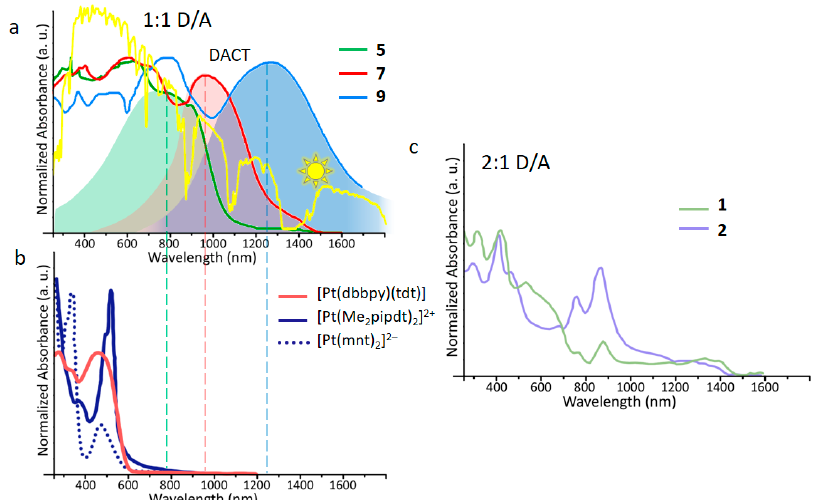
Figure 1. Normalized diffuse reflectance spectra of crystalline samples of: ( a ) 5 (green), 7 (red) and 9 (blue), evidencing the DACT band (shadowed area) in the NIR and the overlap with the AM1 solar spectrum (yellow); ( b ) [Pt(dbbpy)(tdt)], donor unit of 5 and 7 (red), [Pt(mnt) 2 ] 2 − (blue dotted line) and [Pt(Me 2 pipdt) 2 ] 2+ , donor and acceptor (blue solid line) units of 9 , respectively; ( c ) 1 and 2 , displaying no absorption band attributable to DACT in the NIR. Dashed lines are a guide to the eye. Single crystal results have shown that the 1:1 D/A combination ratio gives rise to crystals with a 1:1 D/A stacking only for 5 and 7 (see related section), while a 2:2 -DDAA- stacking is observed for 4 .